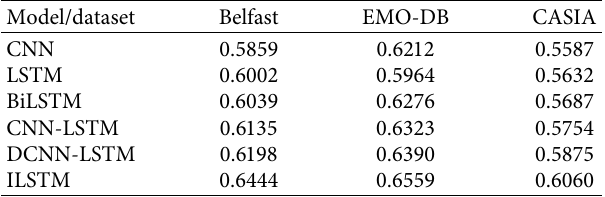
Table 8: Recall rates of different models on each dataset. Model/dataset